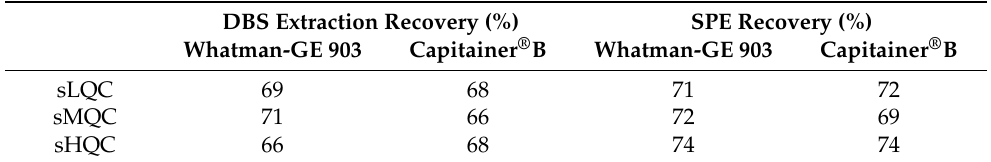
Table 6. Dried blood spot (DBS) and solid phase extraction (SPE) recoveries for lyso-Gb 3 - 13 C 6 in DBSs ( n = 5).